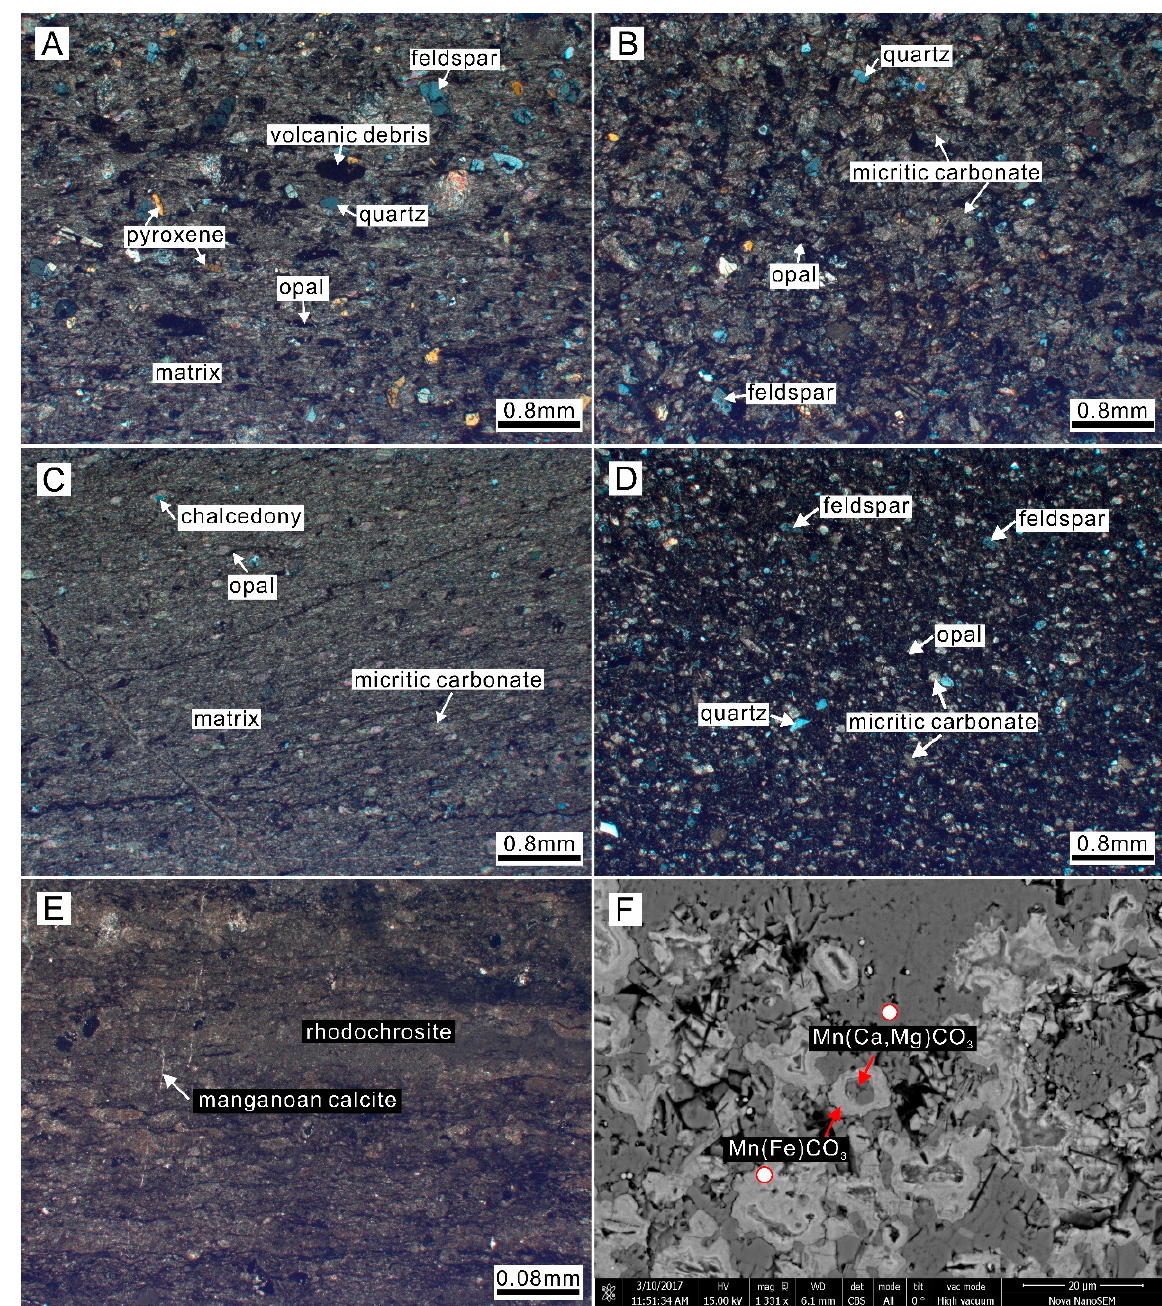
Figure 3. Photomicrographs showing representative textures and petrographic features of the Upper Carboniferous Kalaatehe Formation at the Ortokarnash mine. ( A ). Interlayered fine calcarenite from the topmost 20 m of the volcanic breccia limestone of the first member (crossed polarizers). ( B ). Homogeneous sandy limestone of the second member (crossed polarizers). ( C ). Interlayered slightly laminated argillaceous limestone of the second member (crossed polarizers). ( D ). Homogeneous marlstone of the third member (crossed polarizers). ( E ). Crenulated to wavy laminations in manganese carbonate ore; note minor manganoan calcite veins (crossed polarizers). ( F ). Two generations of rhodochrosite occurring in the manganese ore, with the former containing minor calcium and magnesium, while the latter incorporates iron (backscattered electron image).